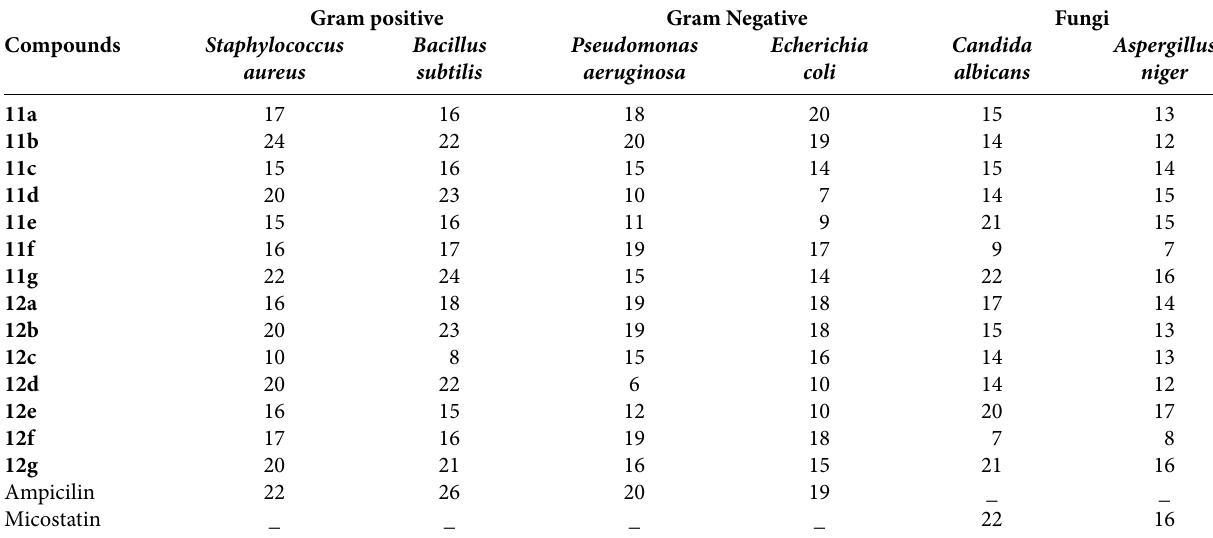
Table 1. Antimicrobial and antifungal activity of 11a–g and